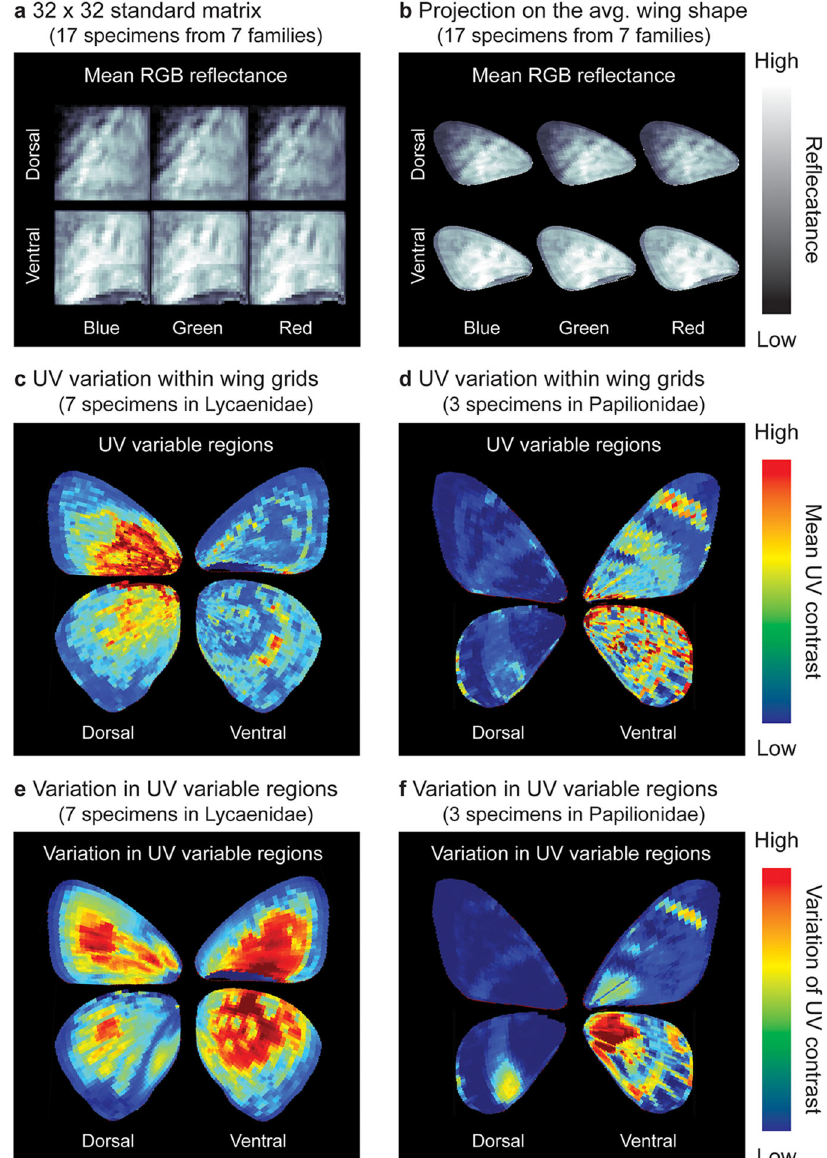
Fig. 5 Re fl ectance summary from exemplar bands according to wing grids. a Summarized gridded re fl ectances in blue, green, and red bands can be b Projected onto the average wing shapes of a selected group of specimens. c , d UV signal (the average UV contrast among species) showing the most common likely highly UV variable regions on the wings. e , f Variation of UV variable regions between species, indicating regions of UV patterning that are highly conserved (blue) versus those that are more actively changing